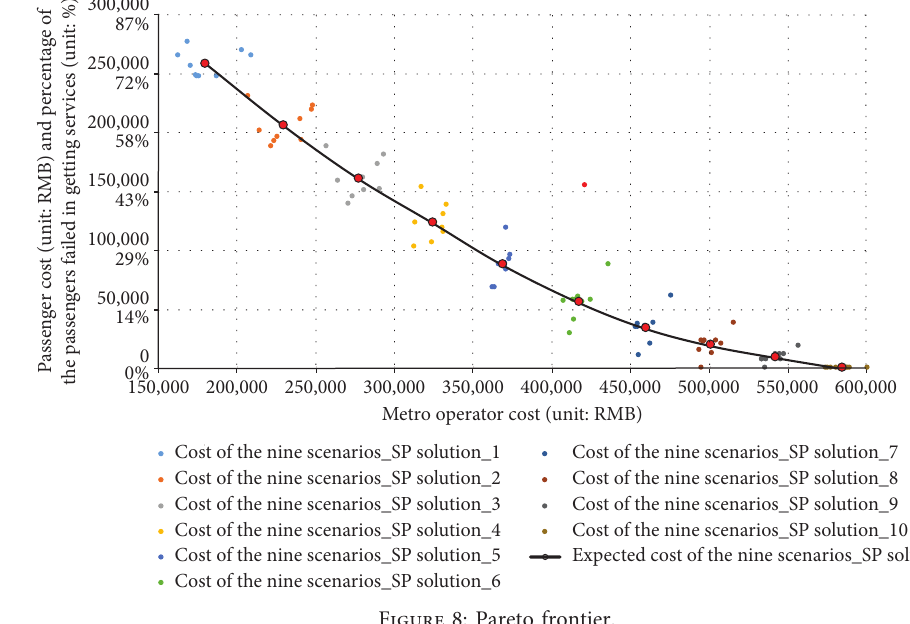
Figure 8: Pareto frontier.